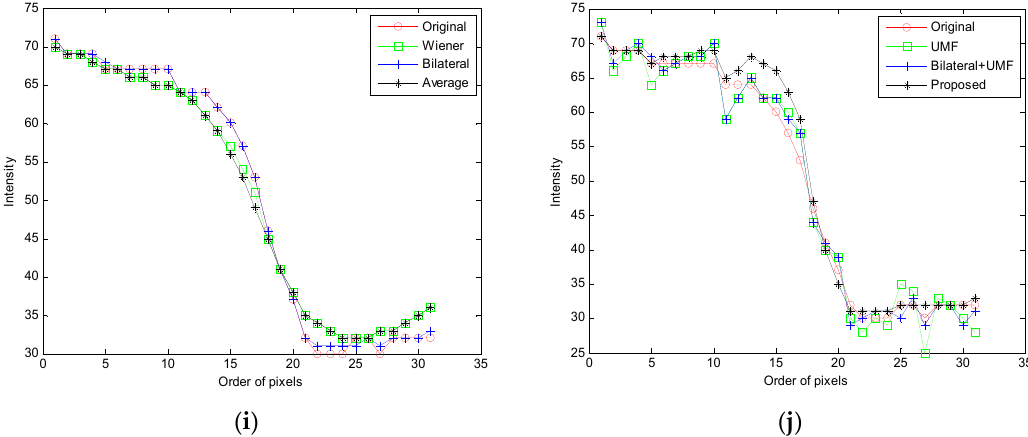
Figure 5. The raw image data of target 3 and its processed resultant images by different filters: ( a ) original data; ( b ) WF; ( c ) AF; ( d ) BF; ( e ) UMF; ( f ) BF + UMF; ( g ) IASF; ( h ) zoomed in images of box H; ( i ) gray level distributions of edge I for ( a – d ); ( j ) gray level distributions of edge I for ( e – g ).